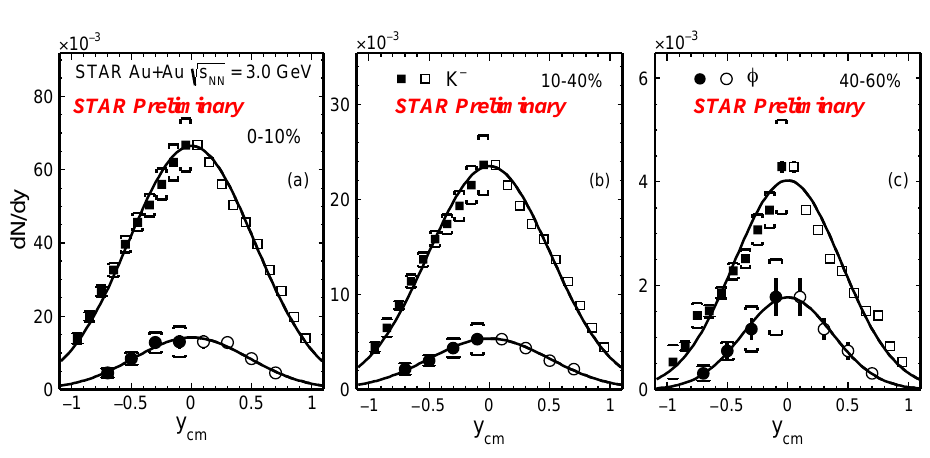
Figure 3: Rapidity distributions of K − and φ meson for various centrality regions, solid symbols are measured data, open ones are reflection. Yields obtained from integrating fit functions to the m spectra are fit with a Gaussian T